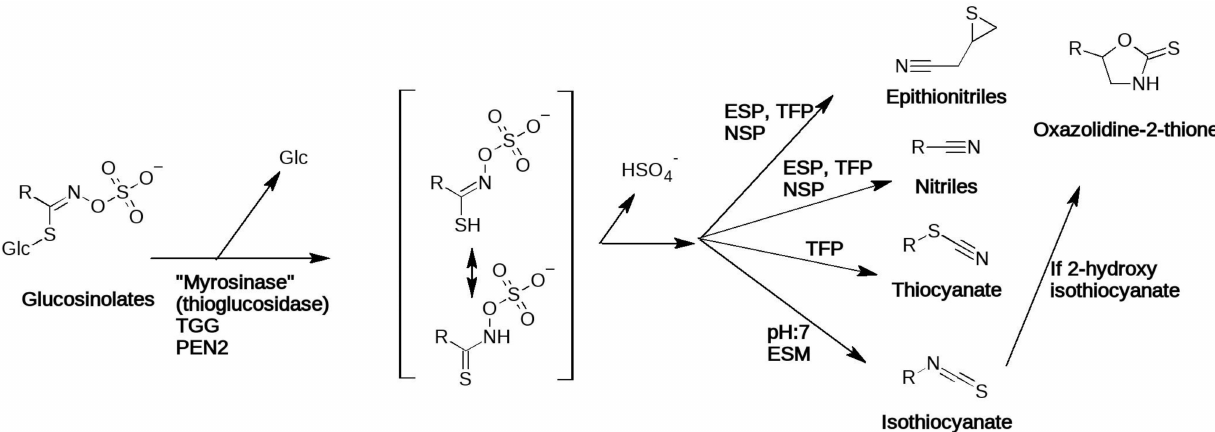
Figure 2. Deglucosylation and subsequent spontaneous rearrangement of glucosinolates into various volatile natural products. Compiled from data in [4,13]. Abbreviations: ESM—epithiospecifier modifier protein; ESP—epithionitrile specifier protein; Glc—glucose; NSP—nitrile specifier protein; PEN2—atypical myrosinase; TGG—beta-thioglucoside glucohydrolase (myrosinase); TFP—thiocyanate-forming